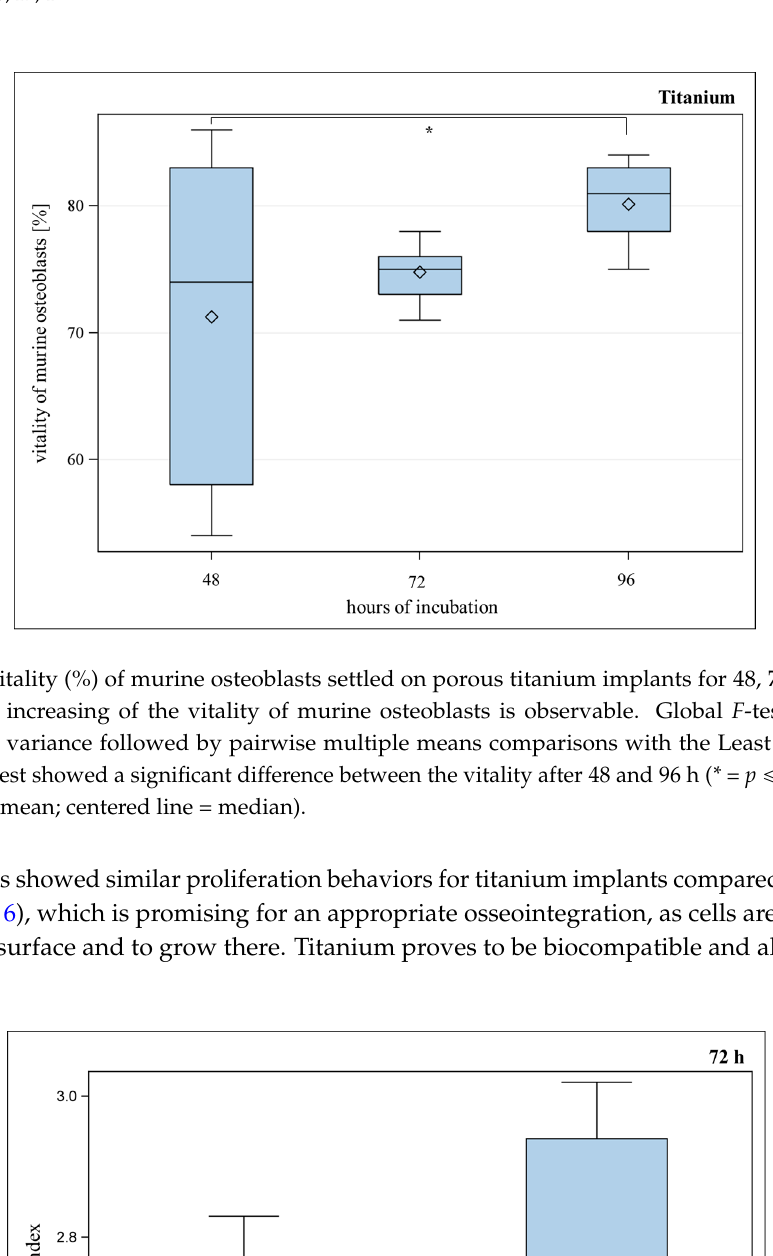
Figure 6. Proliferation index of murine osteoblasts settled on well bottom (WB) compared to porous titanium implants did not show a significant difference between the materials (Global F -test from the analyses of variance and pairwise multiple means comparisons with the Least Significant Difference test, * = p ≤ 0.05, n = 9; rhombus = mean; centered line = median).